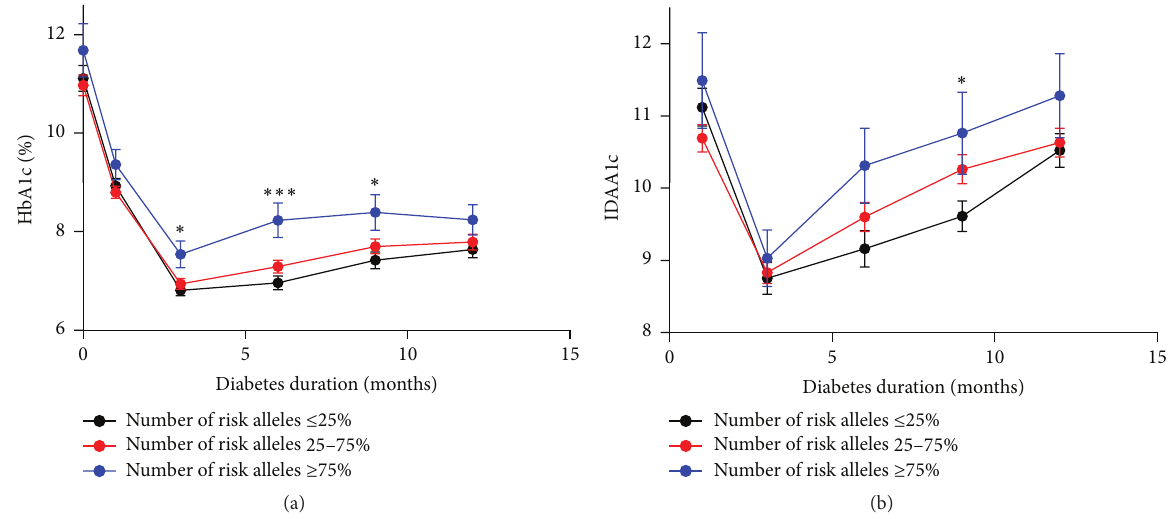
Figure 2: Correlation between HbA1c and IDAA1c levels and risk allele numbers. HbA1c (a) and IDAA1c (b) in carriers with < 25% ( 𝑛 = 65 ), 25–75% ( 𝑛 = 96 ), or > 75% ( 𝑛 = 21 ) risk alleles at 1, 3, 6, 9, and 12 months following disease onset. Data are means ± SEM, ∗ 𝑝 < 0.05 , ∗∗∗ 𝑝 < 0.001 .